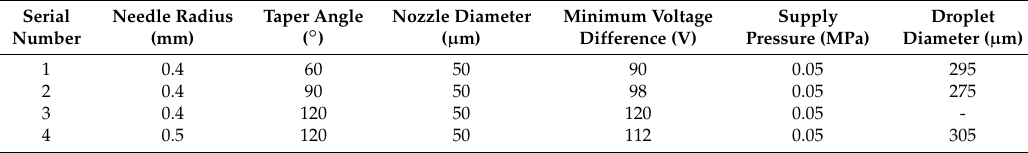
Table 2. Droplet diameter in different configurations and parameters.